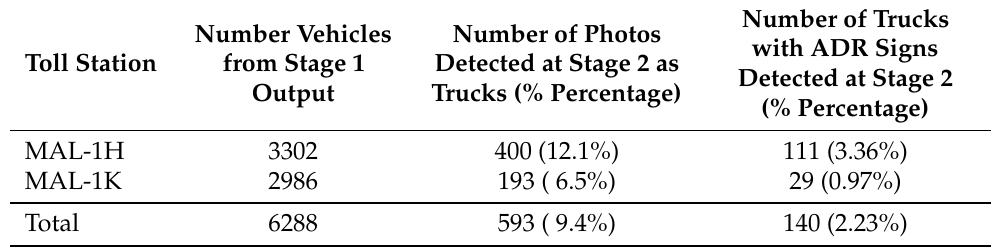
Table 3. Results of the ADR-Det stage 1 and stage 2 parts testing, during March 2021, using two toll posts input